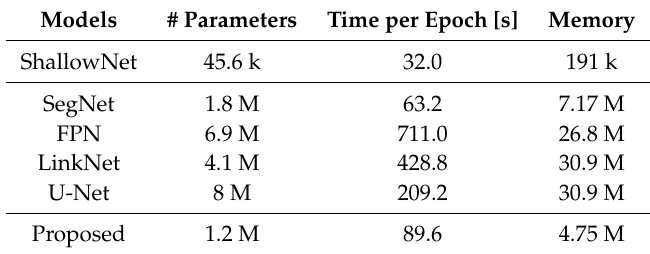
Table 5. General information about the SoA